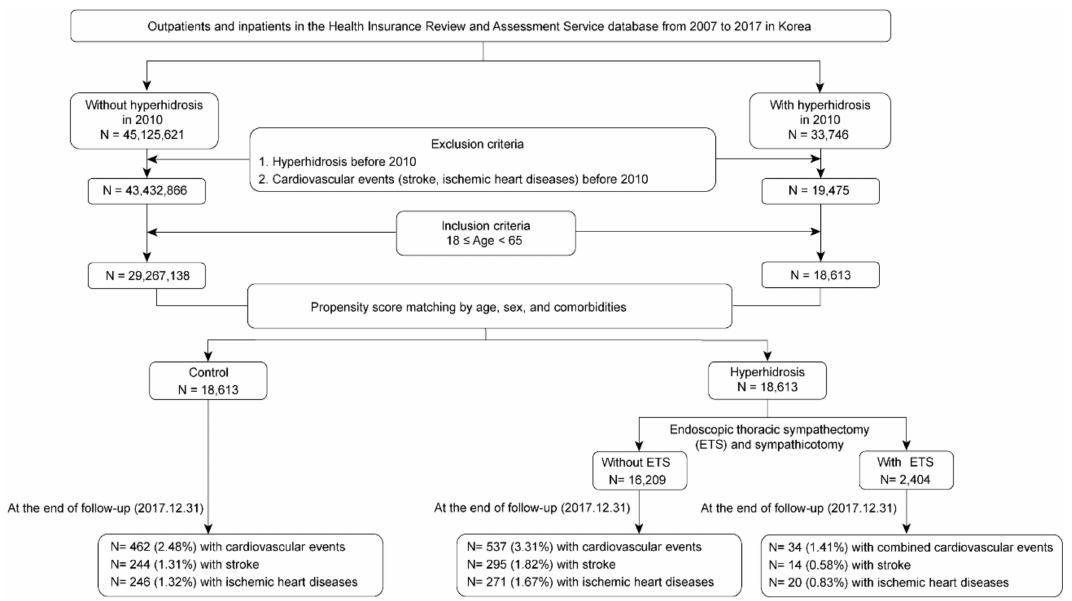
Figure 1. Flowchart of subject selection from the Health Insurance Review and Assessment Service database of